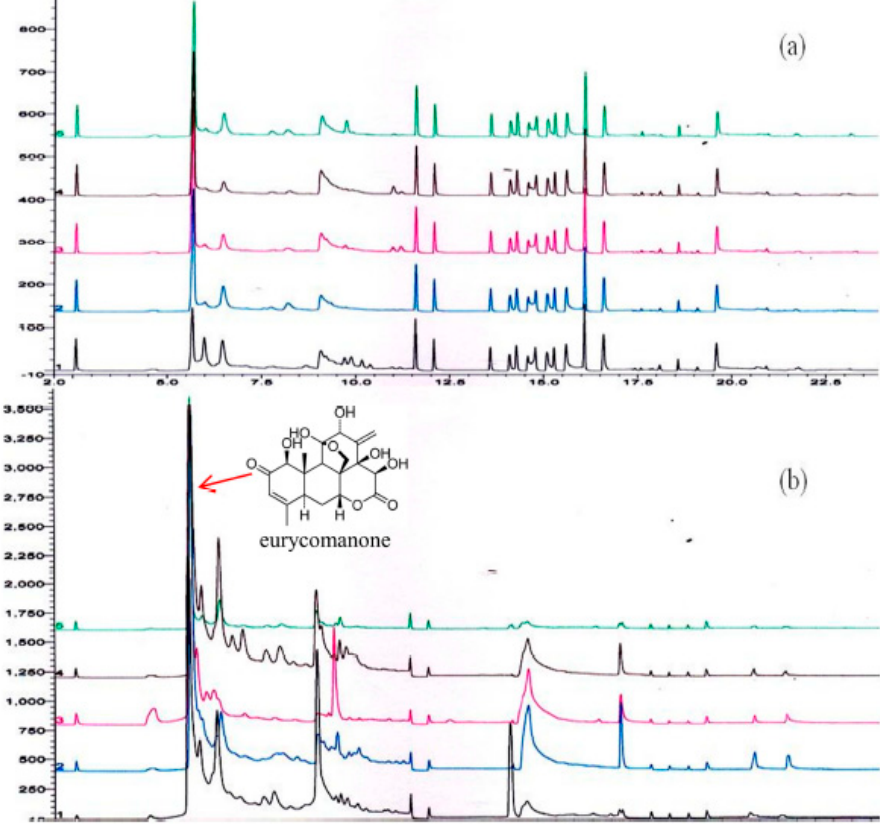
Figure 3. Chromatographic fingerprints of E. longifolia ( a ) roots ( b ) products.